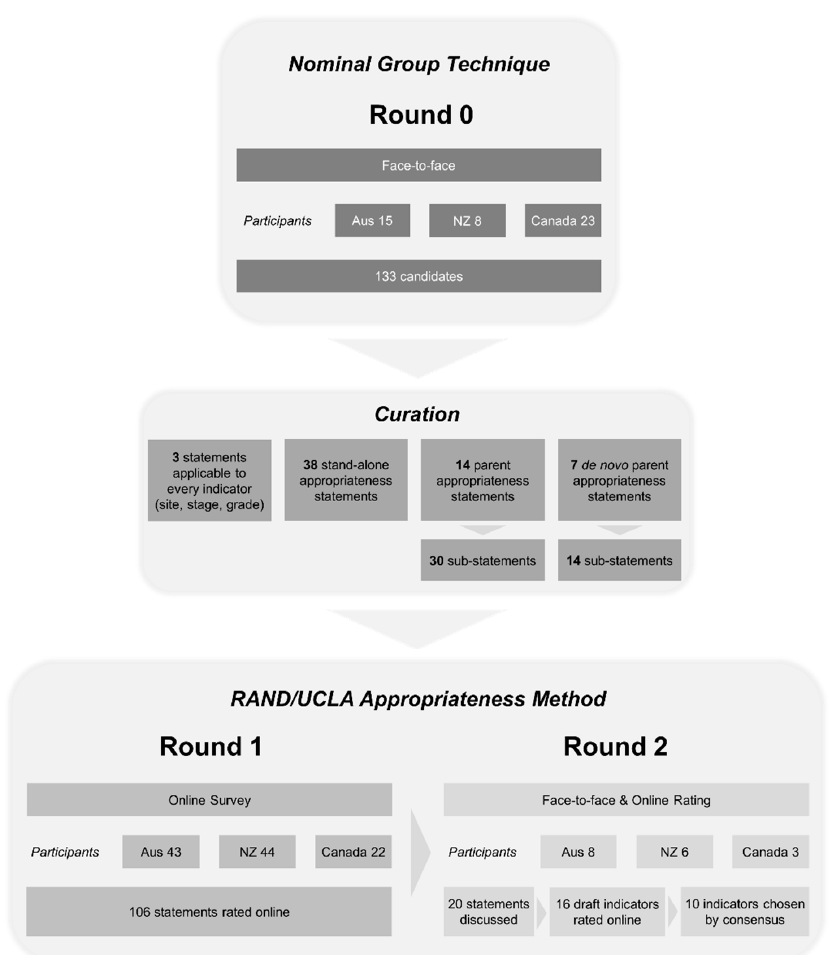
Figure 1. Summary of method. Nominal group technique (NGT) was used to generate 133 “candidates” for neuroendocrine tumour (NET) quality performance indicators (QPIs) (Round 0). These